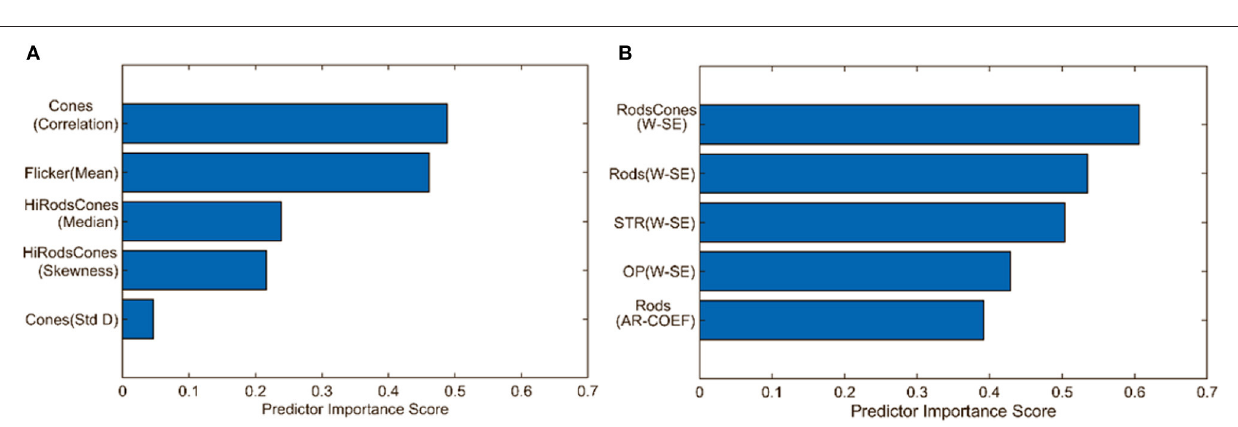
FIGURE 7 | Comparison of predictive importance scores for binary classification using (A) statistical features and (B) wavelet-based features. This bar chart illustrates the superior predictive capability of wavelet-based features. Std D, Standard Deviation; W-SE, Wavelet based Shannon entropy; AR-COEF, Autoregressive